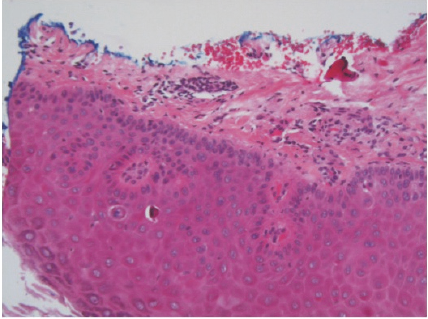
Figure 2: Histology specimen of the tarsal conjunctiva and eyelid margin. Marked hyperkeratosis and parakeratosis of the eyelid margin with extension of this cell atypia into the tarsal conjunctiva. Haematoxylin and Eosin, 100x